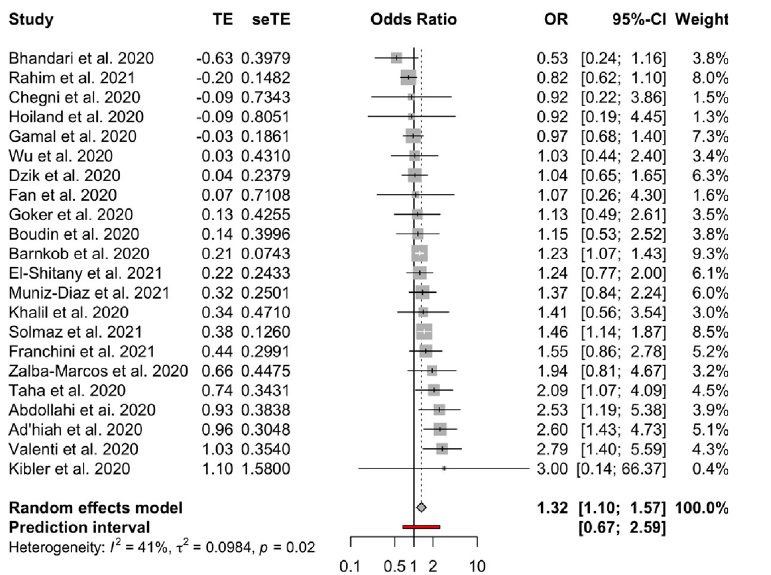
Fig 6. Forest plots for the ABO gene comparison of O vs. AB group.